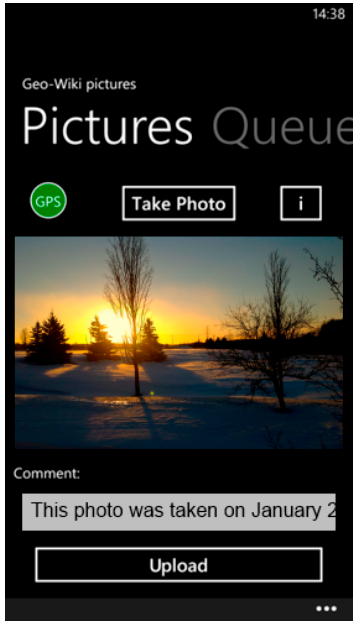
Figure 5. The Geo-Wiki pictures app with an example picture, the optional classification and the comment and value